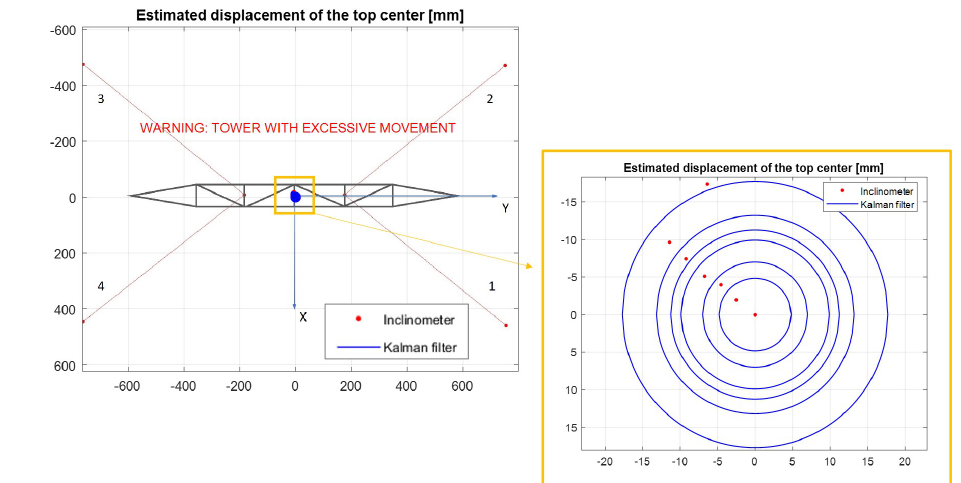
Figure 26. Measured and estimated positions at the top of the tower. Note: tower draft drawing without